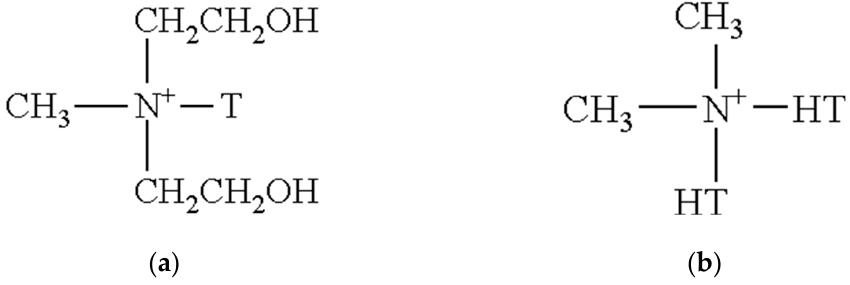
Figure 3. Chemical structures of ( a ) Oleylmethylbis (2-hydroxyethyl) ammonium chloride and ( b ) Di (hydrogenated tallow alkyl) quaternary amine.